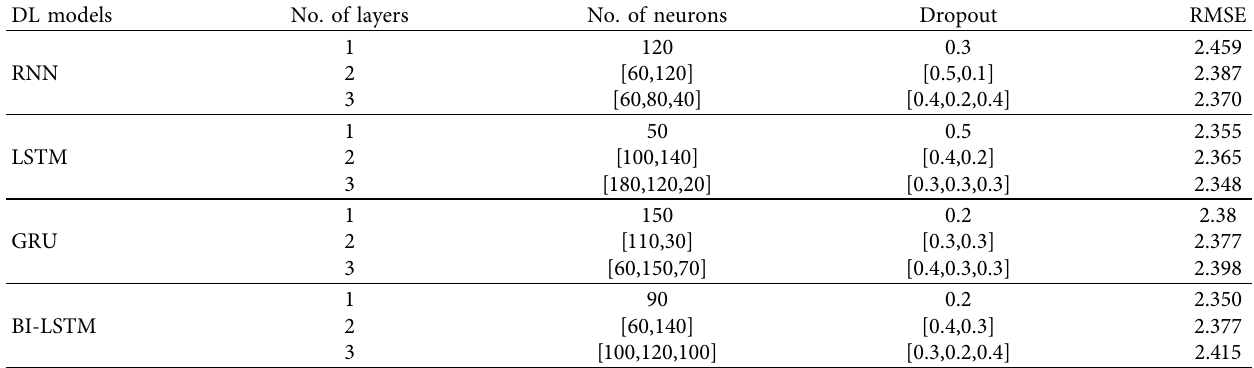
Table 2: The result of DL models for lag of 3 minutes and forecasting 5 minutes in advance. DL models